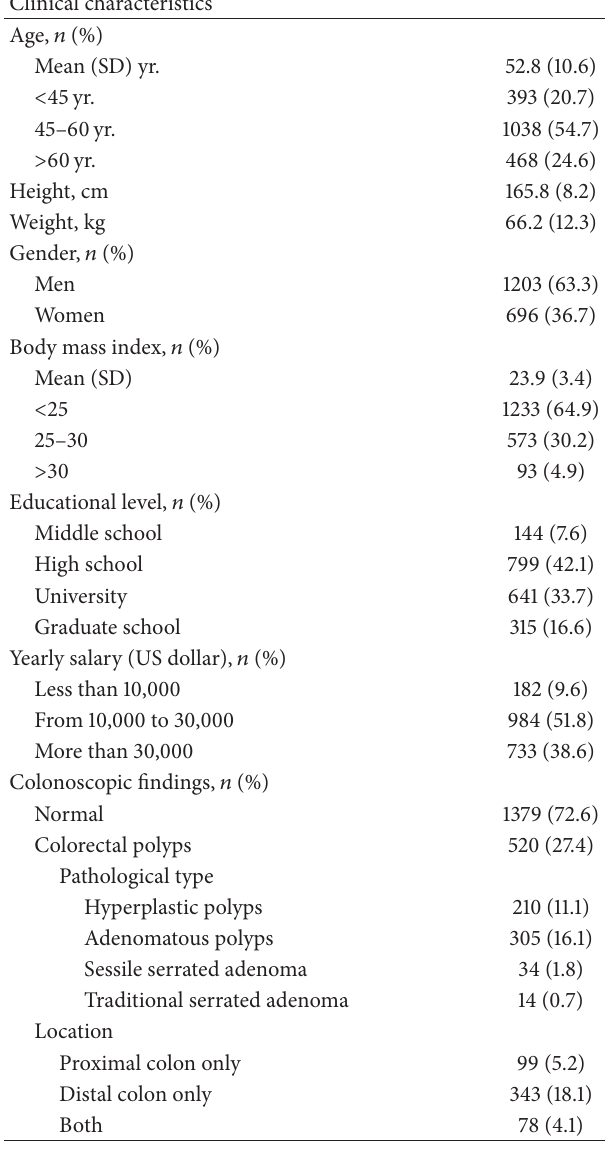
Table 1: Demographics and endoscopic findings of asymptomatic health check-up subjects ( 𝑛 = 1899